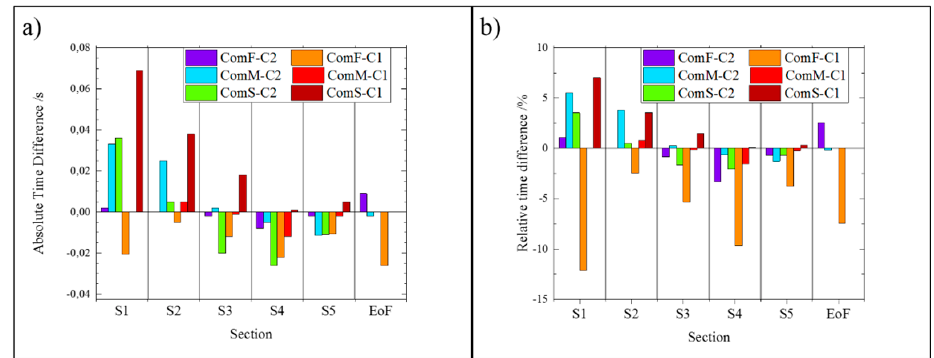
Figure 12. ( a ) Absolute difference between experimental and simulated timings at the selected sections; ( b ) relative difference between experimental and simulated timings at the selected sections.